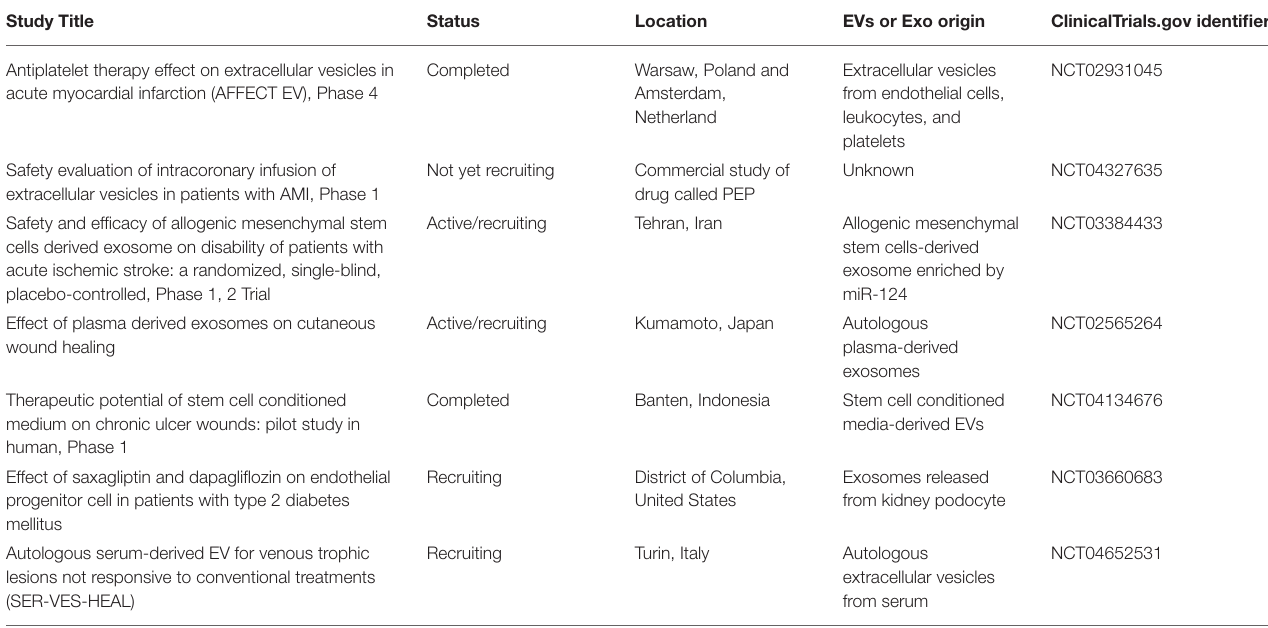
TABLE 2 | Clinical trials on therapeutic applications of extracellular vehicles